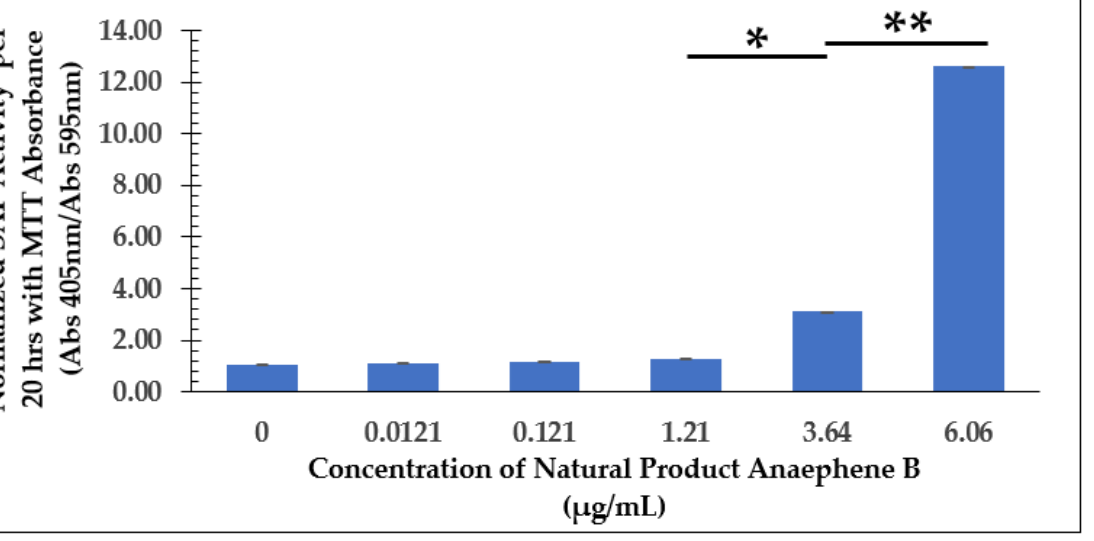
Figure 13. SAP Assay Following Dose-Dependent Study of Anaephene B—Senescence Phase (Cell Culture Age: 648 h) with SAP Enzyme Activity Normalized by MTT Cell Viability Data. Values are the mean and standard deviation for n = 3 replicates. * denotes p < 0.05 between 1.21 µg/mL and 3.64 µg/mL of anaephene B. ** denotes p < 0.05 between 3.64 µg/mL and 6.06 µg/mL of anaephene B.